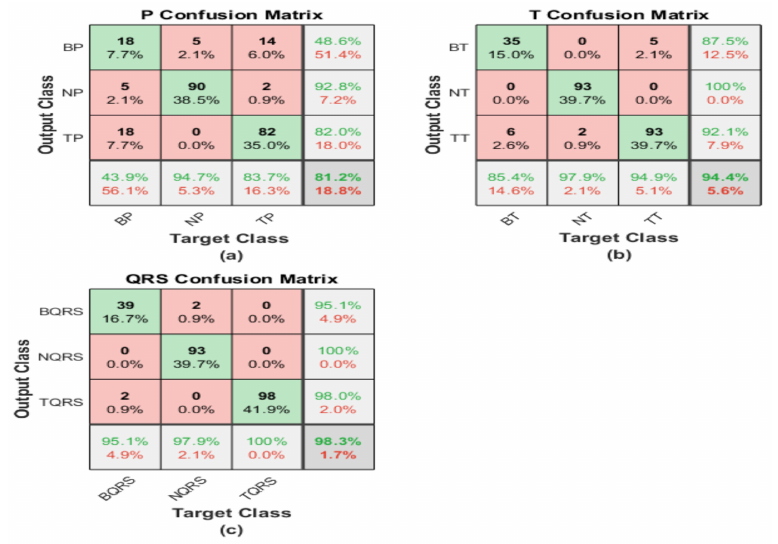
Figure 13. Confusion matrices of ECG SGs using ShuffleNet: ( a ) P-waves SG; ( b ) T-waves SG; ( c ) QRS-waves